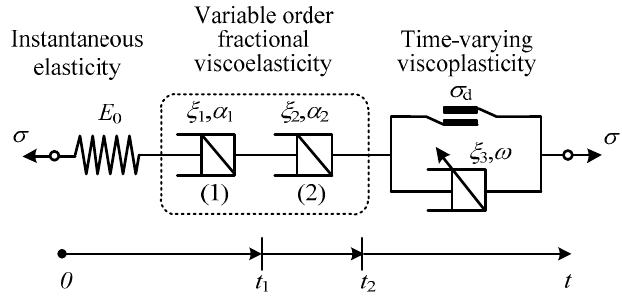
Figure 4. Fractional viscoelastoplastic creep model with variable order.